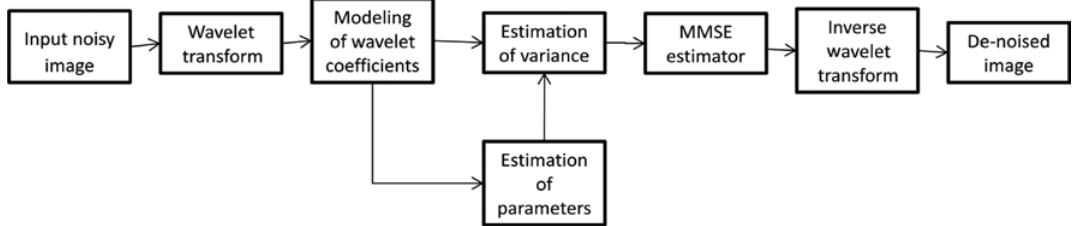
Figure 6: Block Diagram of Bayesian Multiresolution Approach for De-noising MR